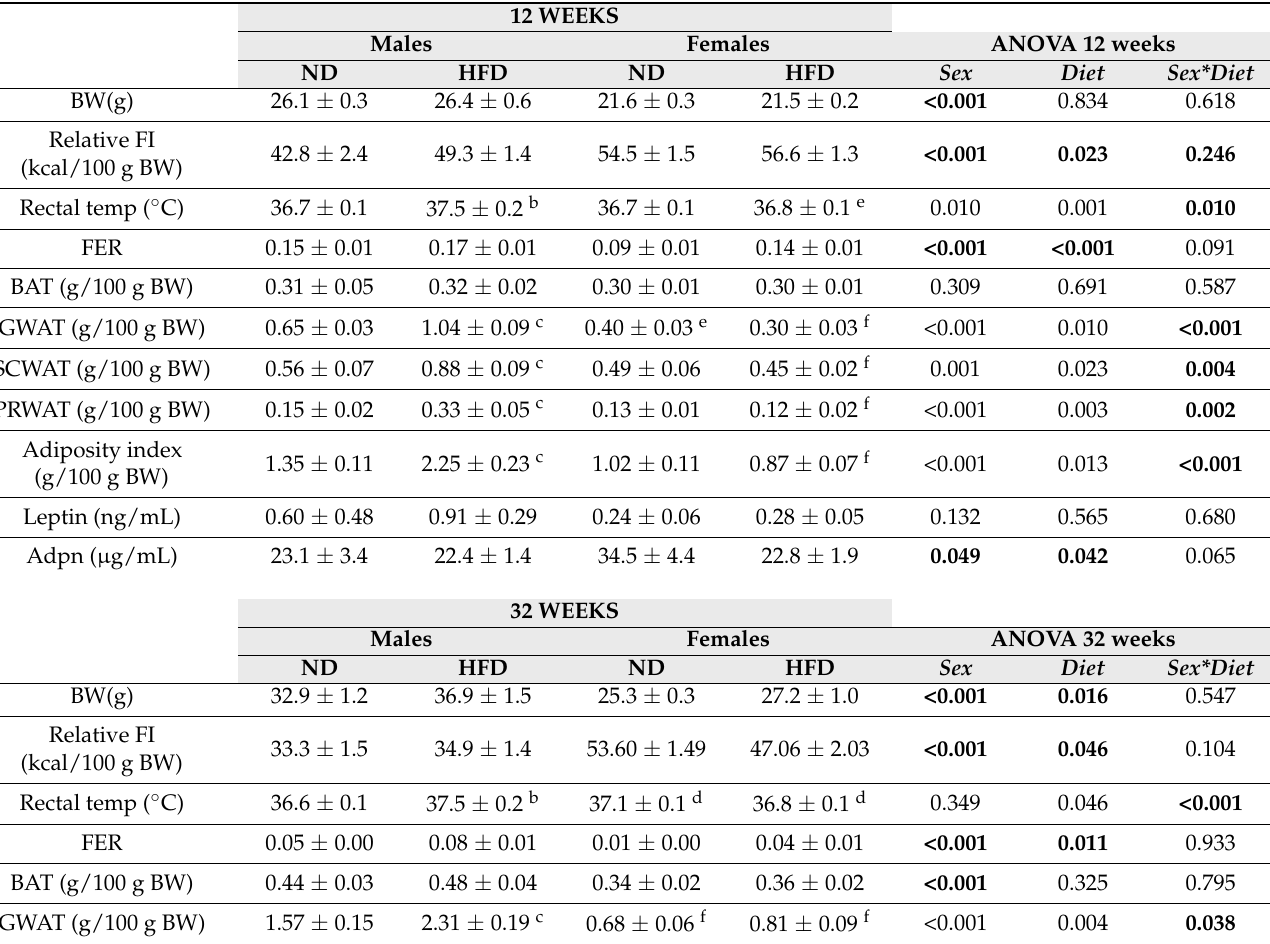
Table 1. Effect of sex and diet on the body weight, food intake, body composition and homeostasis in 12- and 32-week-old